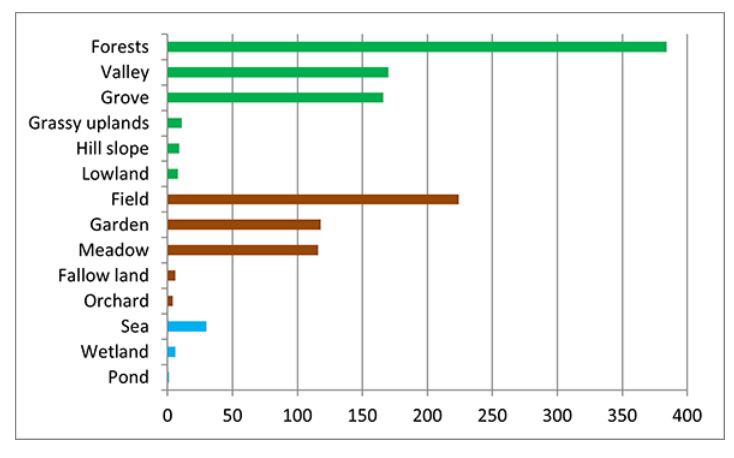
Figure 5 Representation of landscape elements in Slovak folk